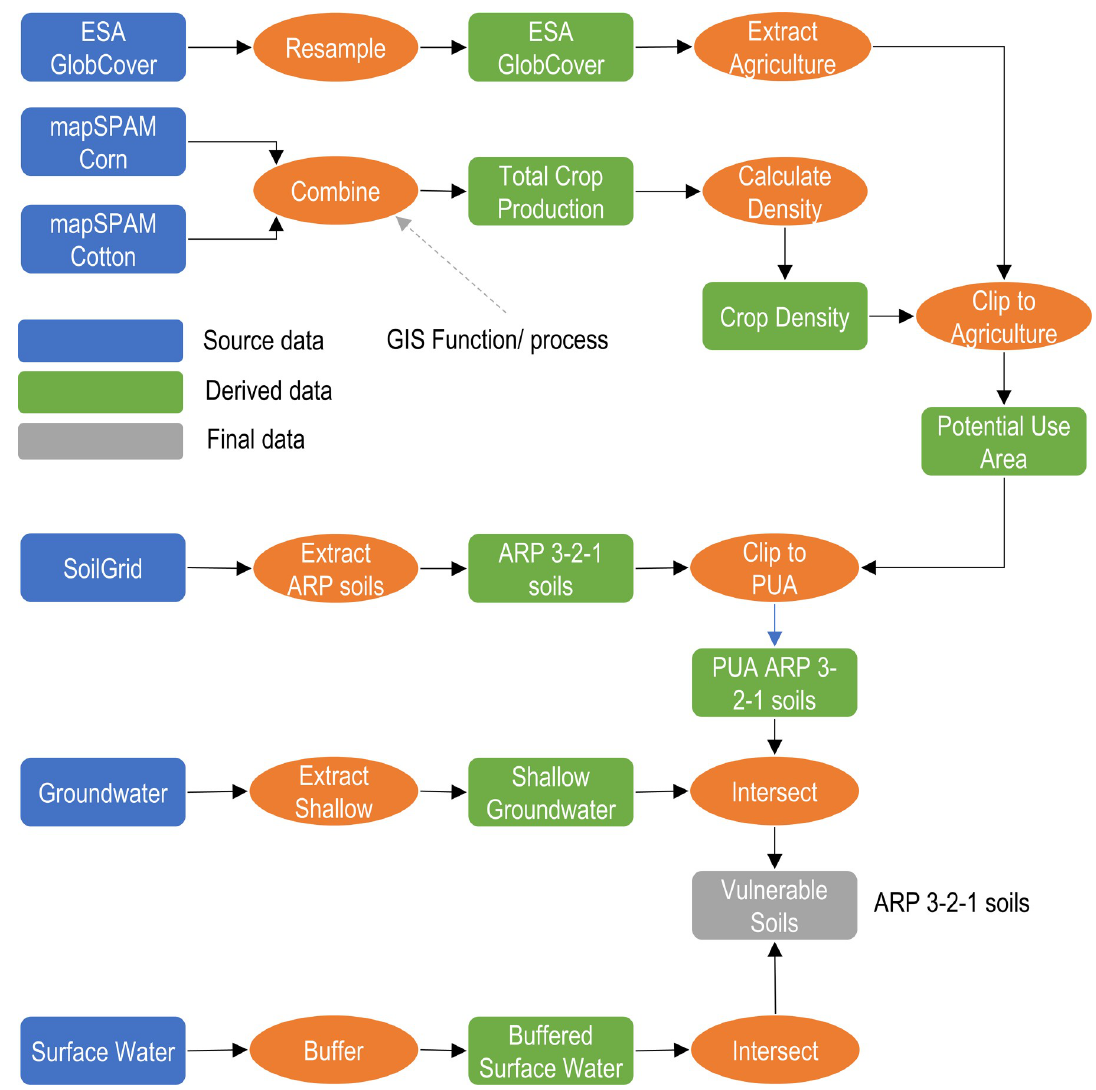
Fig 8. GIS data processing flow showing the source data, derived data, final datasets and key GIS processing